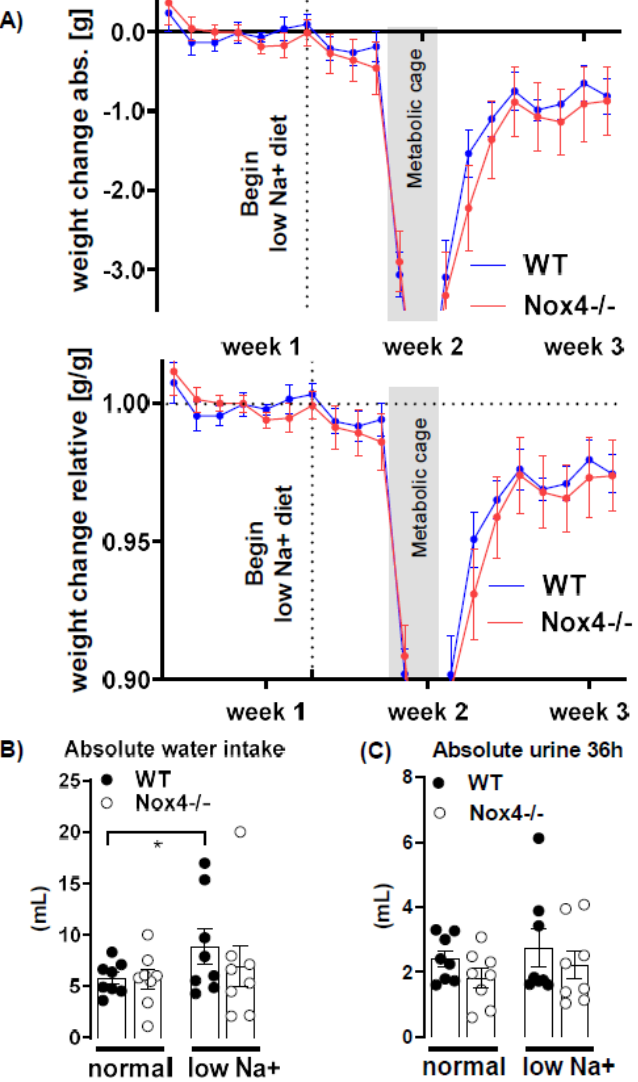
Figure 3. Effect of diet on weight, water intake und urine excretion. ( A ): absolute and relative weight change during the experiment. The grey box indicates the time mice were kept in metabolic cages. Vertical dotted line indicates the beginning of a low sodium diet. ( B , C ): Absolute water intake and urine production determined in the metabolic cage before and 3 days after the initiation of a low sodium diet. (36 h collection time) n = 8. * p < 0.05 paired Wilcoxon test, data are mean ± SEM.